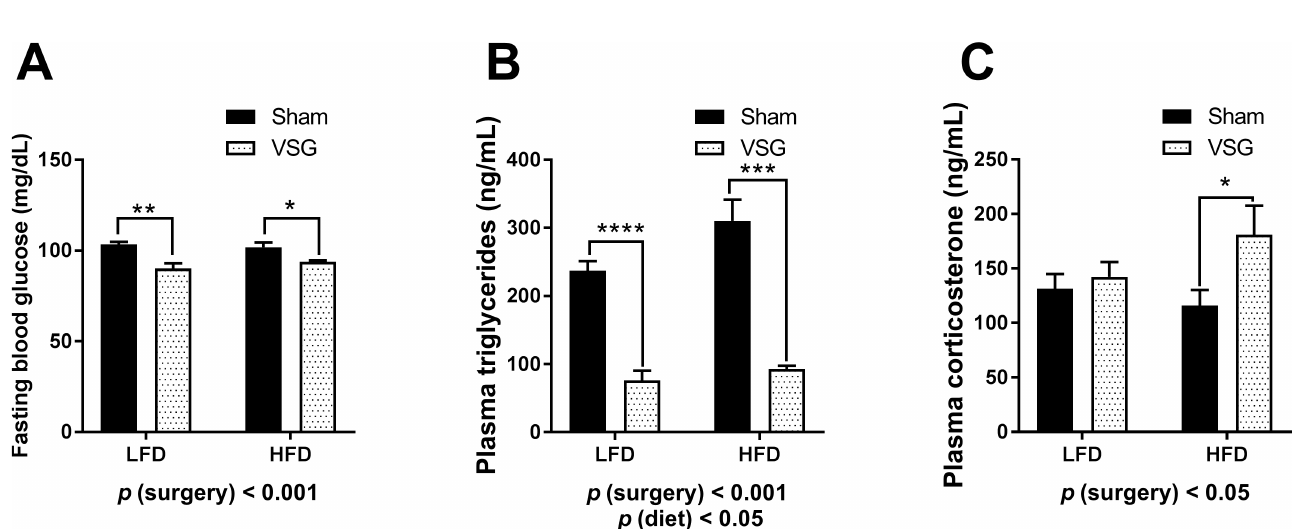
Fig 4. Plasma analytes in female rats. (A) Fasting plasma glucose (B) Fasting plasma triglycerides (C) Early light cycle corticosterone levels (D) . Data are presented as mean ±SEM. N = 5-7/group.